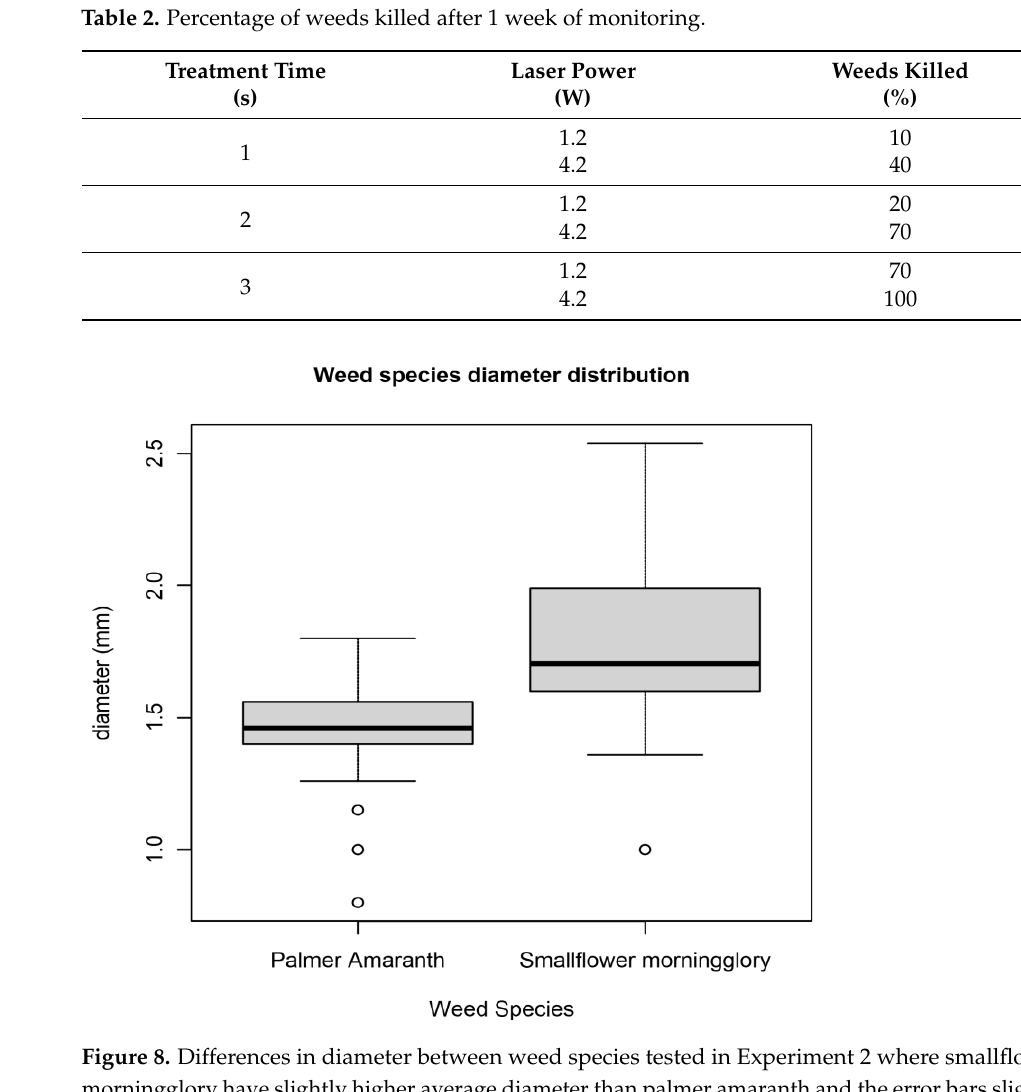
Figure 8. Differences in diameter between weed species tested in Experiment 2 where smallflower morningglory have slightly higher average diameter than palmer amaranth and the error bars slightly overlap to imply a possible statistical difference.